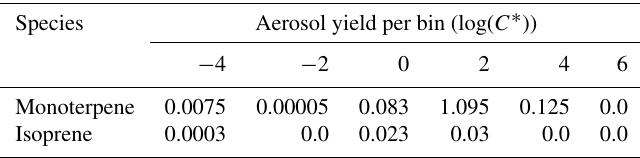
Table 1. Product fractional mass yields for lumped monoterpenes and isoprene (GoAmazon only) in each VBS bin in TOMAS. The monoter- pene yields are based on Henry et al. (2012), with the yield for the C ∗ = 10 − 4 bin representing the average yield from oxidation of OH of the monoterpene species examined in Jokinen et al. (2015). The isoprene yields are from Tsimpidi et al. (2010), remapped to fit the TOMAS model’s bin scheme, with the yield to the C ∗ = 10 − 4 bin from isoprene OH oxidation from Jokinen et al. (2015).